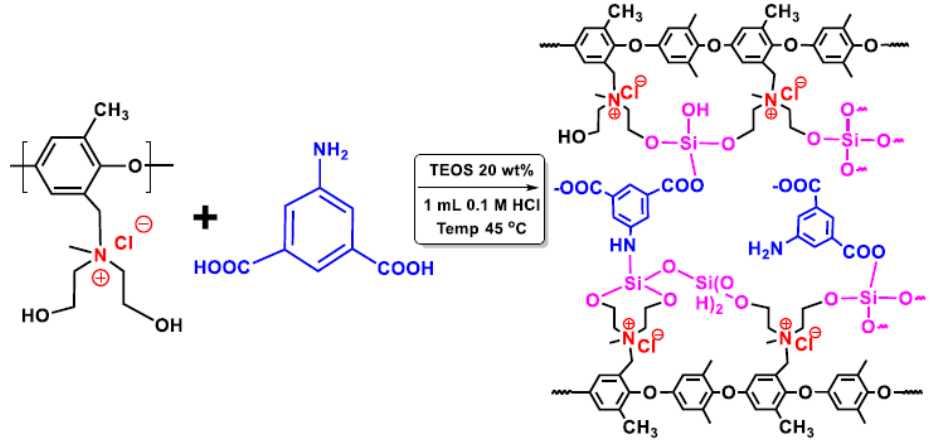
Figure 8. Zwitterionic membrane for electrodialysis. Reprinted from Reference [98] with permission from Elsevier.